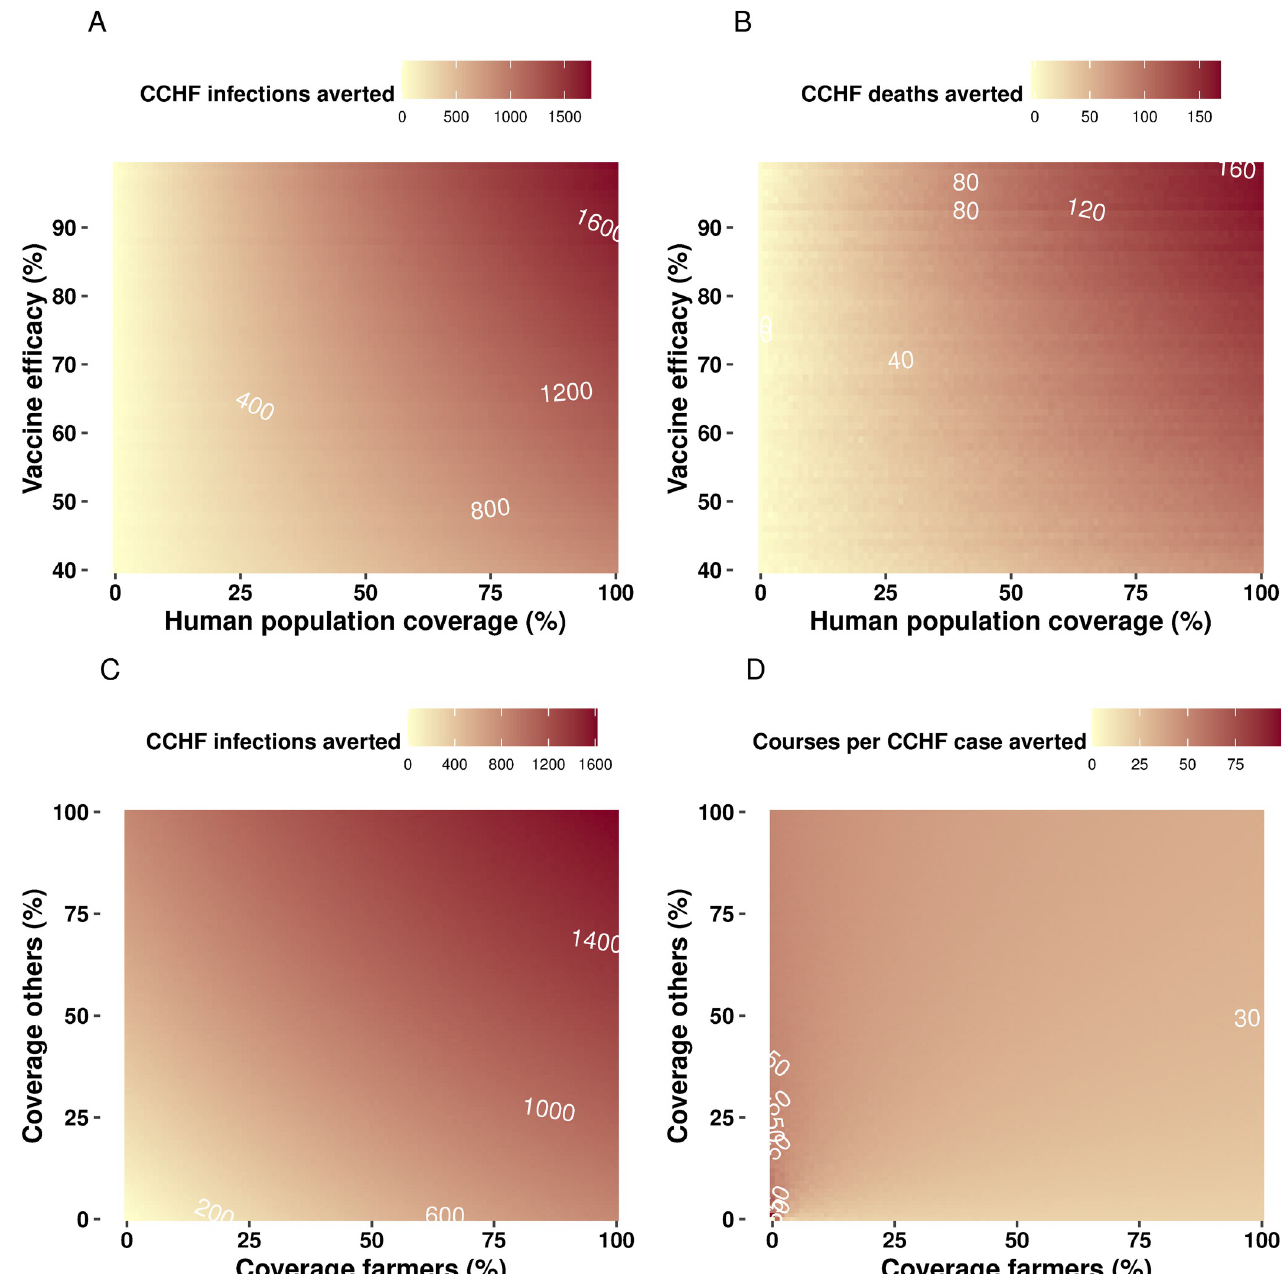
Fig 4. Exploration of vaccine efficacy and coverage on incidence and mortality reductions. (A) A contour for combinations of vaccine efficacy and vaccine coverage among humans. Interventions are introduced as a single campaign approach. White solid lines reflect the frontier of effect measured as CCHFV infections averted. (B) shows the combination efficacy vs human vaccination coverage and effect measured as CCHFV deaths averted. (C) and (D), the effect of different levels of coverage among farmers and other occupations on infections averted and doses per case averted, respectively.